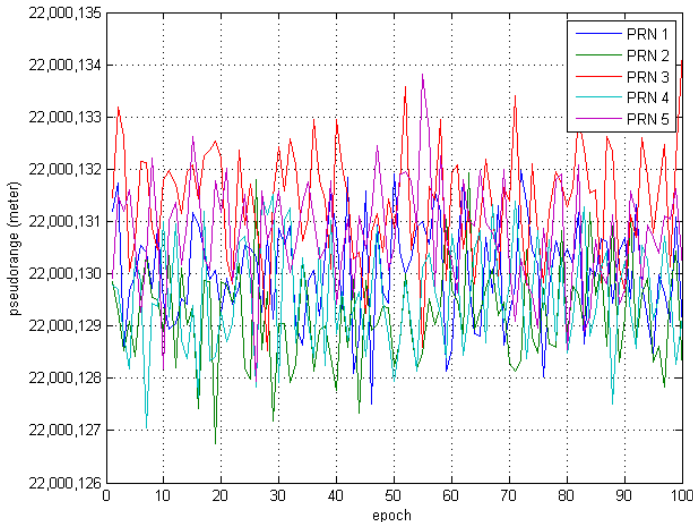
Figure 11. Generated Pseudorange